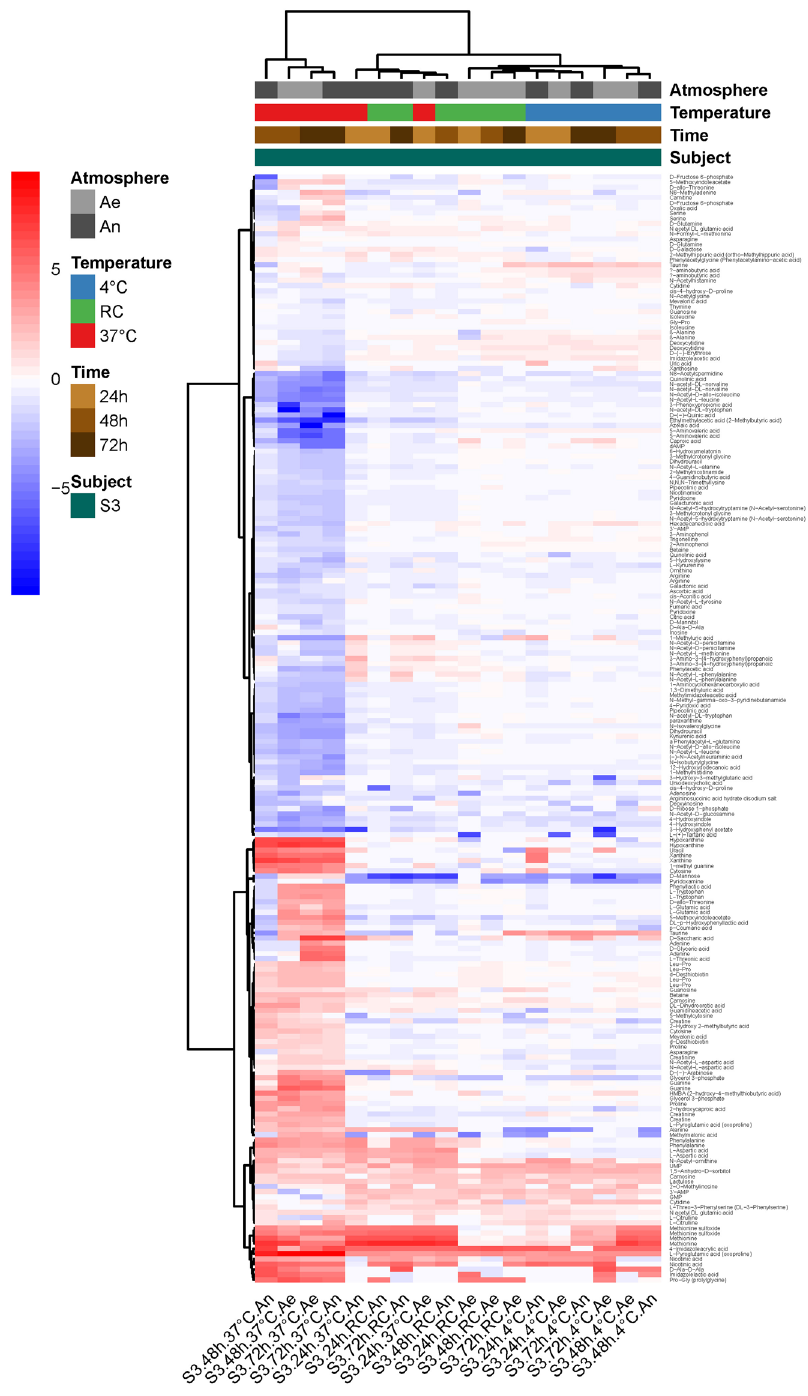
Figure 4. Heatmap of log2(condition/baseline) for metabolite abundance in cultures of a raw sample from S3 (the same as that on Fig. 3). Conditions are the same as on Fig. 3. Baseline is metabolite abundance in the culture within two hours of stool